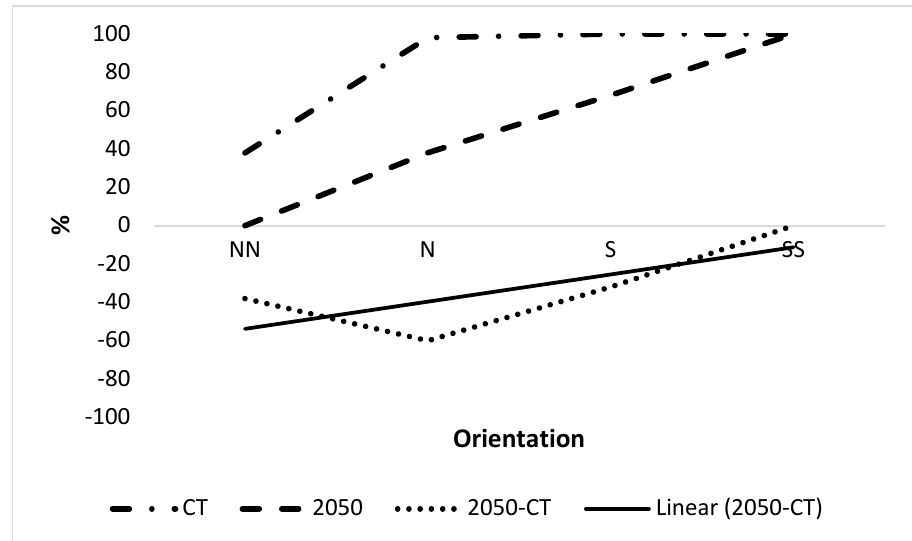
Figure 1. Latitudinal trend of combined suitable climate. Orientation abbreviations are NN, N, S and SS which represent north-north, north, south and south-south respectively of Nigeria excluding parts with unsuitable climate for growing OP as indicated in Figure 2. CT is current time.